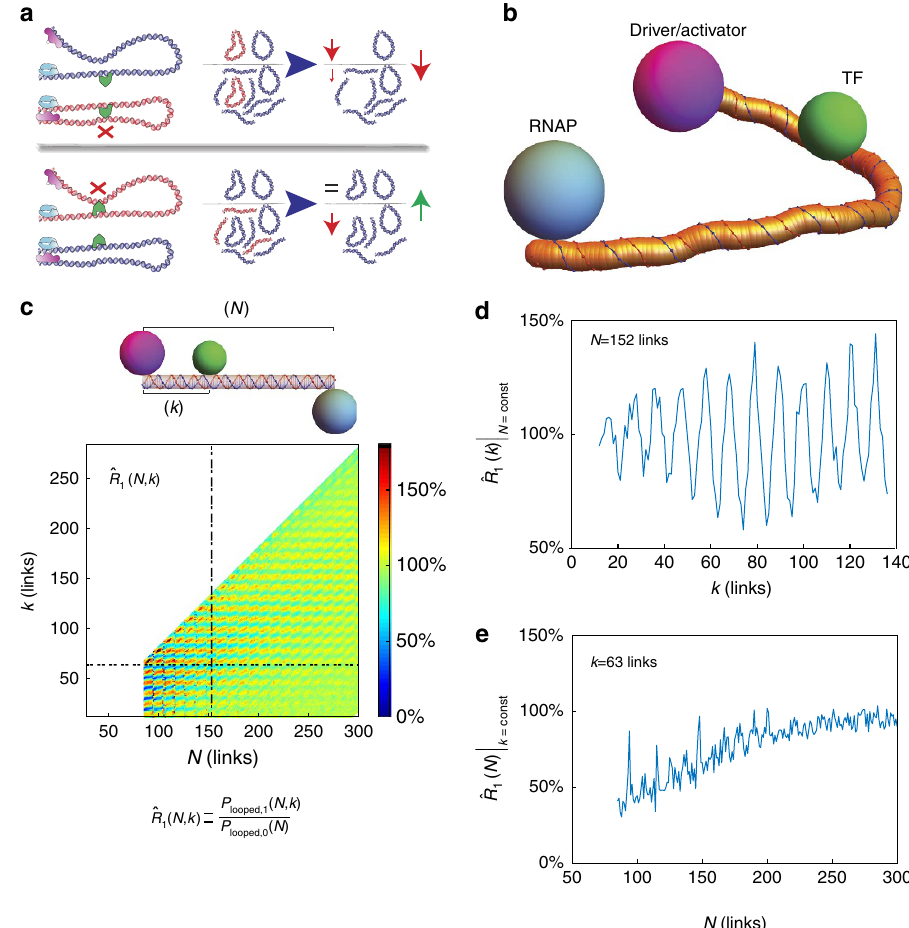
Figure 1 | Transcriptional regulation via an excluded volume effect. ( a ) Schematic representation of the looping probability ratio corresponding to the effects of a TF excluded volume on the probability of looping. We focus on two extreme binding configurations: first, the TF is positioned inside the loop ‘in- phase’; thus, its binding site will be separated from the activator’s by an integer multiple of the helical repeat ( B n (cid:3) 10.5bp). Second, the TF is positioned outside of the loop or ‘out-of-phase’ from the activator; thus, the binding site separation must be an odd integer multiple of half of the helical repeat ( B ( n þ 1/2) (cid:3) 10.5bp). In the top schematic ( a , top), the transcription factor bound ‘in-phase’ excludes many of the looped configurations that were available to the polymer not bound by the TF. As a result, the propensity of the bound complex to loop should be reduced as compared with a complex not bound by the TF. This should lead to a repression regulatory effect. Conversely, the ‘out-of-phase’ TF is positioned outside of the loop, which mainly results in the exclusion of previously available non-looped configurations. This results in a slight increase in the propensity of the TF bound complex to loop. Consequently, the out-of-phase configuration should yield a small upregulation or activation-like effect ( a , bottom). Together, the ‘in-phase’ and ‘out-of- phase’ arrangements of the TF should generate a regulatory response that oscillates between down and upregulation as a function of the position of the TF within the loop. ( b ) Sample conformation of a thick chain with three protrusions generated using the self-avoiding WLC (SAWLC) algorithm. ( c ) Heat-map of the simulated looping probability ratio for a thick chain. Top: schematic with protrusions simulating a minimal enhancer with a single TF-binding site as a function of looping length ( N ) and TF protrusion position ( k ). The size of the TF protrusion was set to be 5.44nm in diameter. Bottom: schematic showing the definition of the looping probability ratio. ( d , e ) One-dimensional cross-sections of the simulated probability ratio heat map at constant N ¼ 152bp and k ¼ 64bp, A closer examination of various one-dimensional cross- sections of the heat map shows additional phenomena. For a cross-section at constant N (Fig. 1d), the amplitude of the oscillations between the up-regulation maxima and down- regulation minima increases the further the protrusion is positioned away from the chain origin, with a maximal amplitude reached at the position which bisects the chain ( k E N /2).